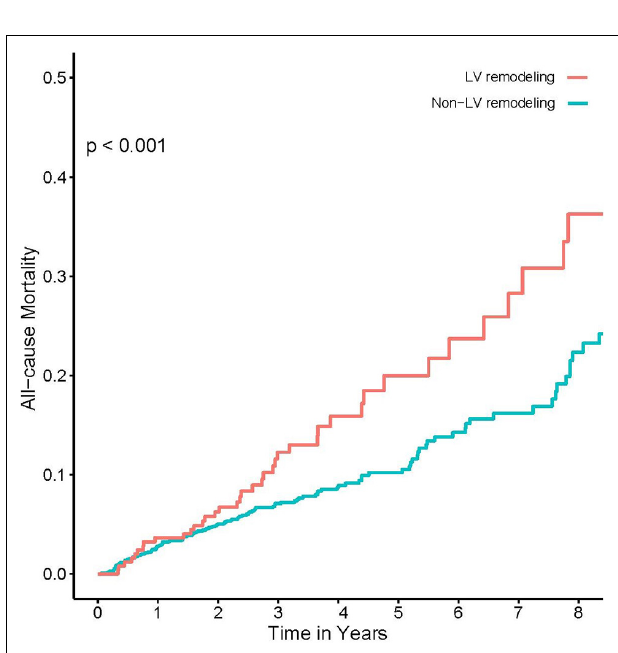
FIGURE 4 | Kaplan-Meier curves for long-term all-cause